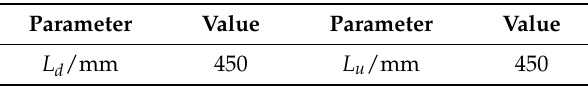
Figure 9. Input–output of the active suspension.